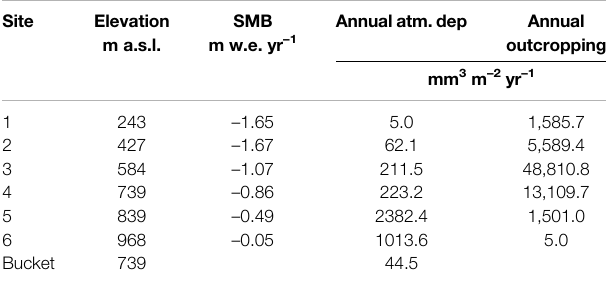
TABLE 1 | Elevation, surface mass balance (SMB), and annual abundance of atmospheric deposition and outcropping of ISP. Site Elevation m